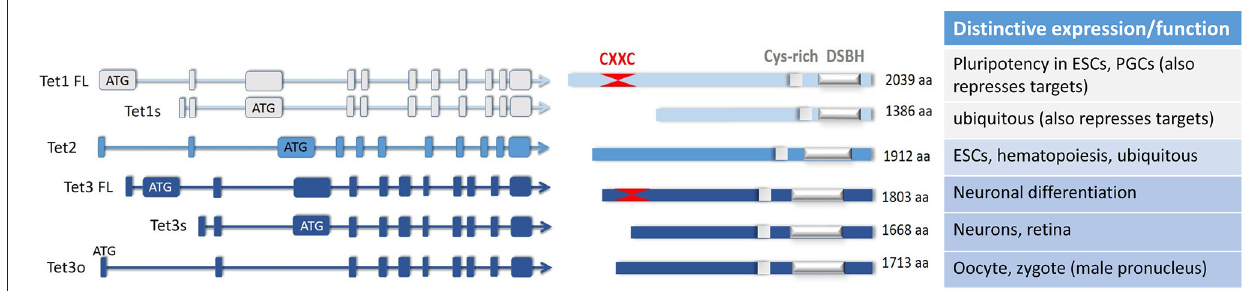
FIGURE 1 | The major isoforms of the three TET enzymes, and their differential expression and or functions elucidated to date. A number of TET enzyme isoforms are produced as a result of differential promoter usage and/or alternative splicing, giving rise to distinct proteins of varied sizes (FL, full-length; s, short; o, ovarian isoform; aa, amino acids). All of these TET enzyme isoforms contain the C-terminal catalytic domain comprising the double-stranded β -helix domain (DSBH) which is adjacent to a Cys-rich region. As marked, one of the TET1 and one of the TET3 isoforms also have at their N-terminus two Cys4-type zinc finger motifs which make up the CXXC domain. Some of the distinctive or unique characteristics of these isoforms are noted; other details can be found in the main